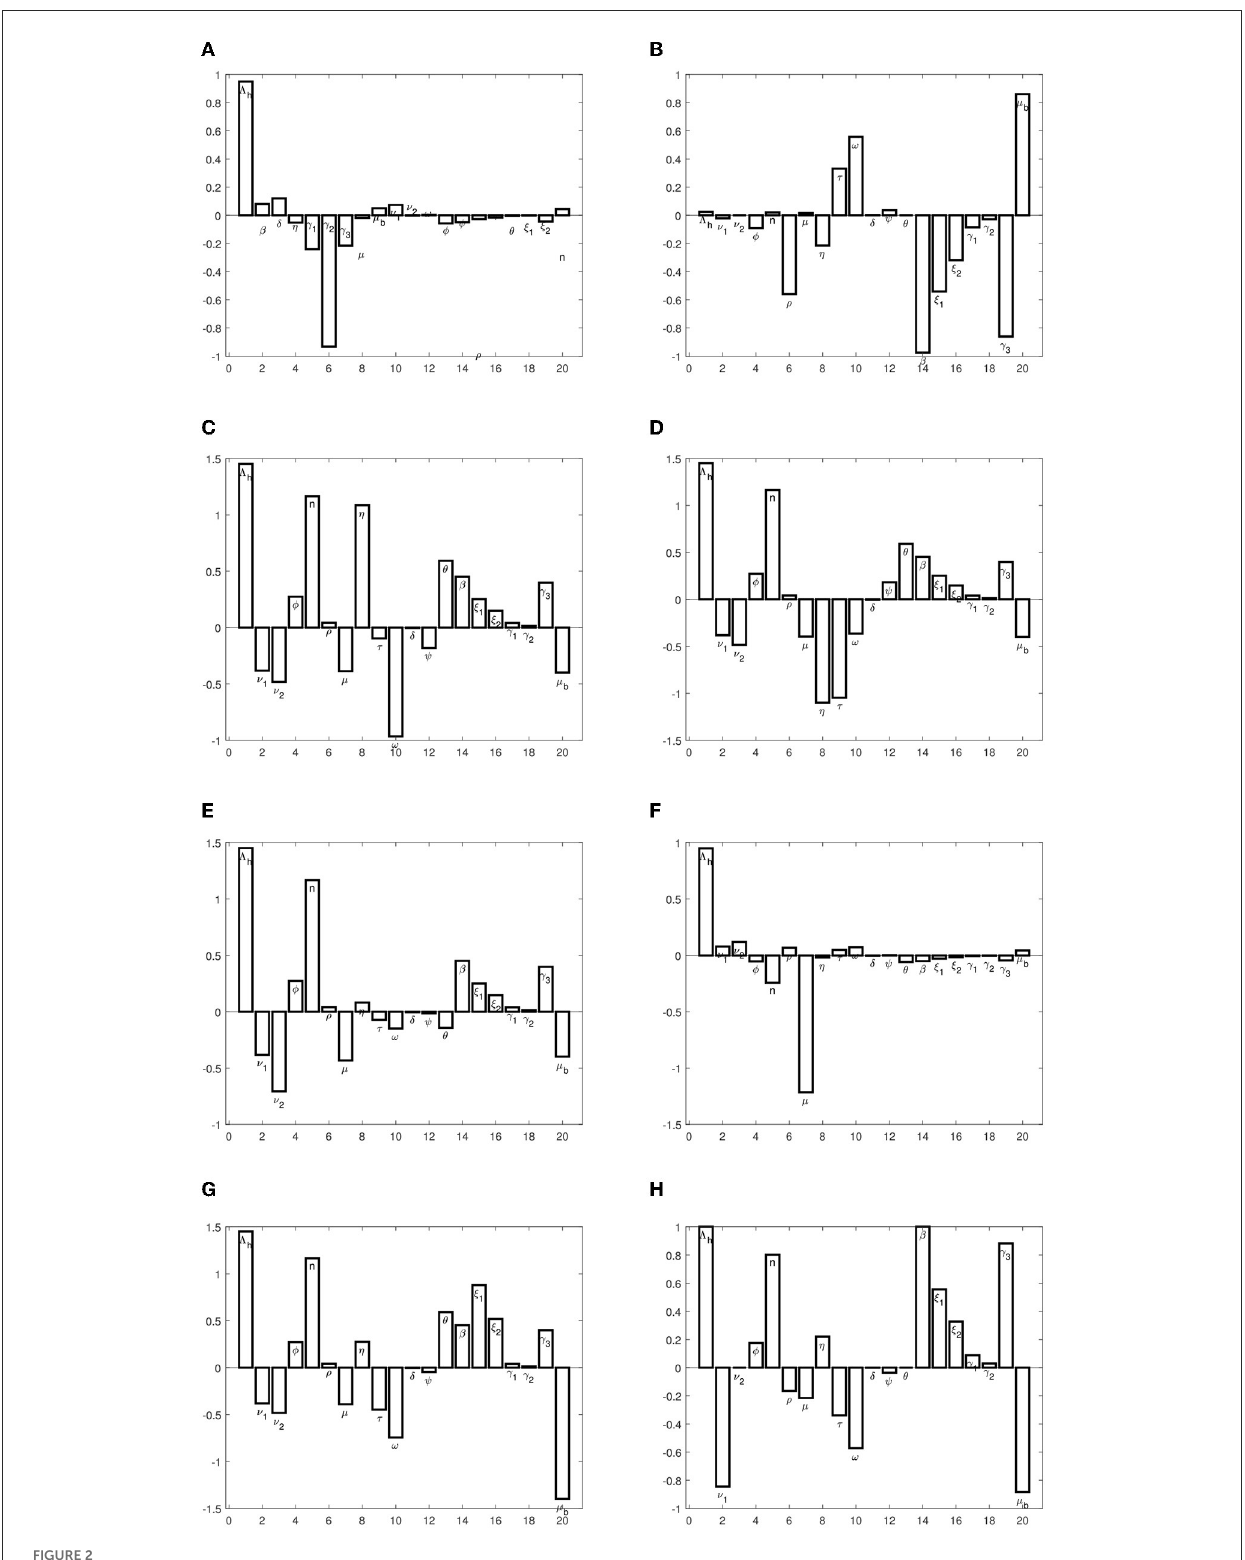
FIGURE2 (A–H) Graphs of sensitivity indices of endemic equilibrium point, and R 0